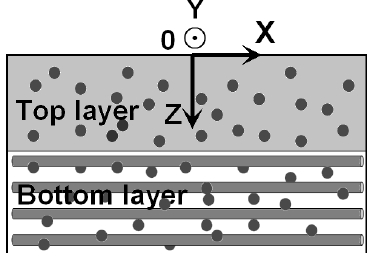
Fig. 4. Schematic diagram of two-layer model for cancerous skin tissues. The top layer is isotropic, the bottom layer is anisotropic and both layers may include absorption e®ect.